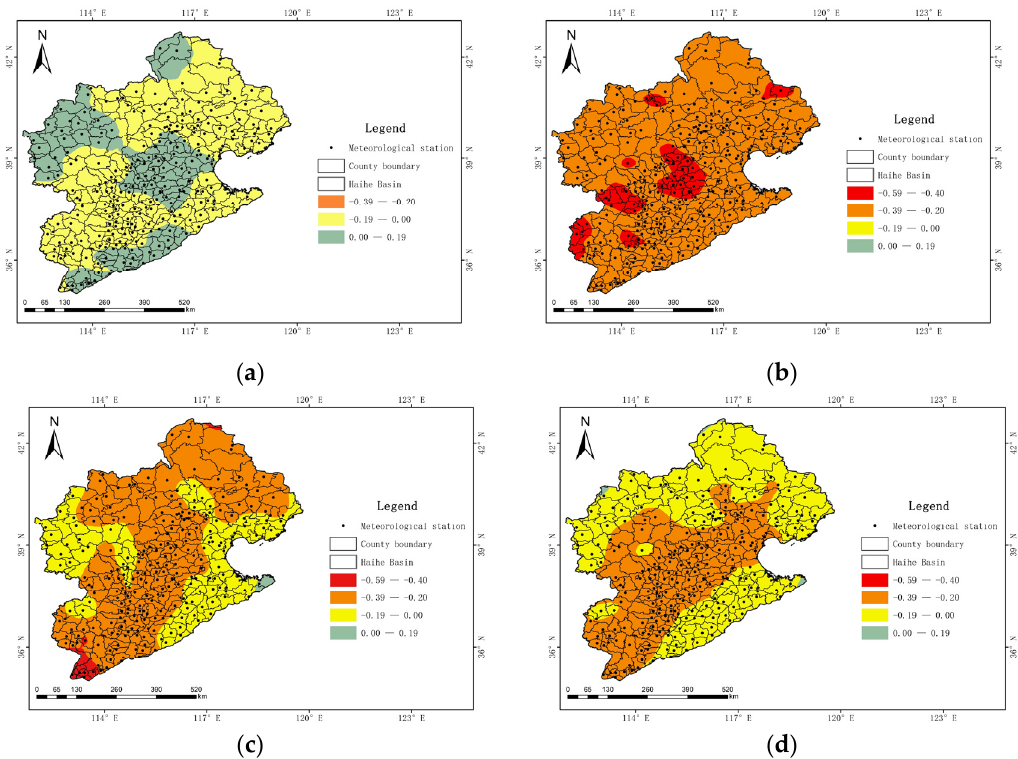
Figure 8. Spatial distribution of Spearman’s correlation coefficients for different seasons. ( a ) Spring; ( b ) summer; ( c ) autumn, and; ( d ) winter.